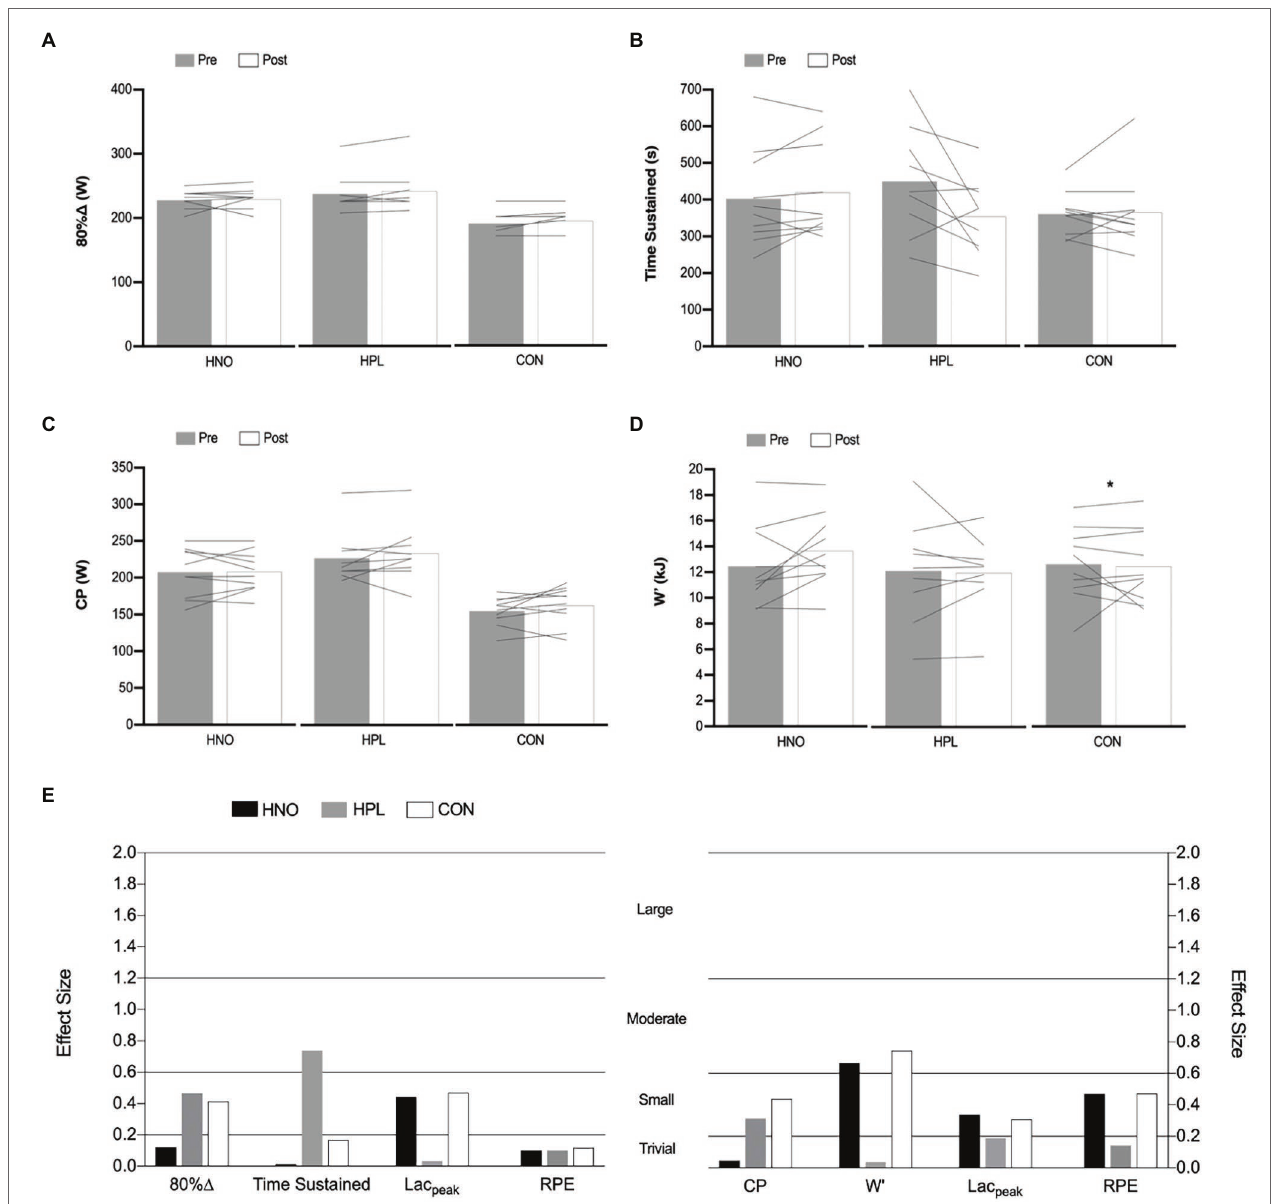
FIGURE 2 | The effects of 4-weeks training in the 80% ∆ intensity and time sustained of the T lim test (A,B) and on the CP and W ′ of the 3AOT (C,D) presented as mean (columns) and individual values (lines) in both pre- (gray) and post-intervention (white) periods following high-intensity exercise training sessions performed in hypoxia with NO 3 − (HNO), in hypoxia with placebo (HPL) and in normoxia with placebo (CON). Mean corresponding effect size (post-intervention mean—pre- intervention mean/square root of the sum of the two standard deviations minus 2*correlation coefficient) for HNO (black), HPL (gray), and CON (white) groups in both T lim and 3AOT-related parameters are presented in (E) . Threshold values considered for effect size were “trivial” (<0.2), “small” (0.2–0.6), “moderate” (0.6–1.2), and “large” (1.2–2.0). *Differences between pre- and post-intervention period ( p <